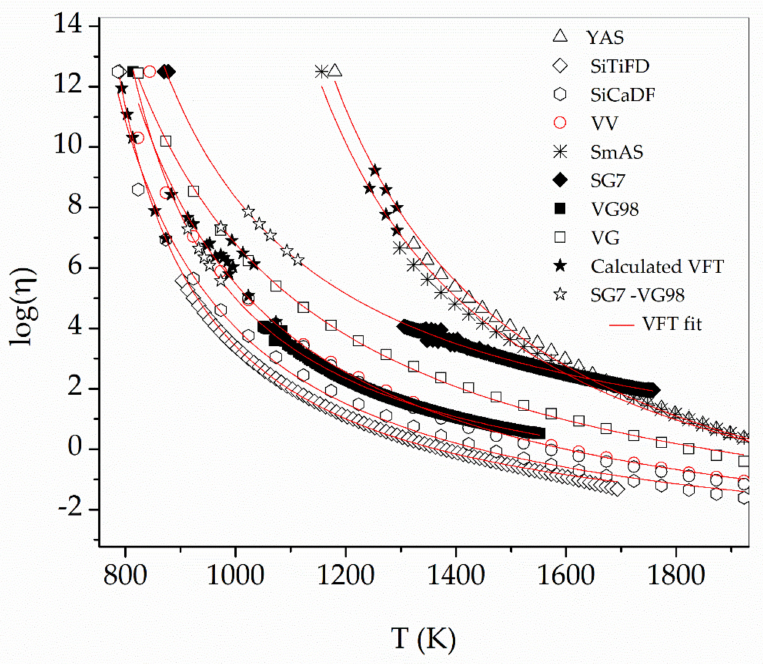
Figure 7. T , τ , η values presented in Table 2 and used to build the master function (solid stars). Expected viscosity values for test glasses SG7 and VG98 (hollow stars). Region of validity of this method (region where stars are